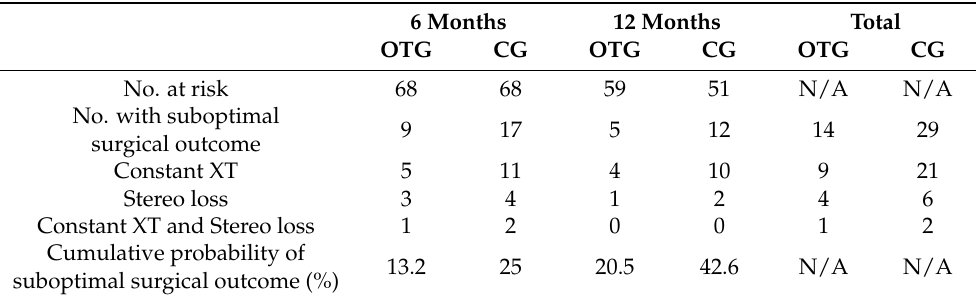
Figure 2. Graph showing the cumulative probability of suboptimal surgical outcome by 12 months from Kaplan–Meier analysis (n = 136). The dotted line represents the cumulative probability of suboptimal surgical outcomes at 12 months after surgery in intermittent exotropia patients, as shown in a previous article. Table 3. Suboptimal Surgical Outcome by 12 months in the Orthoptic Therapy Group and Control Group.